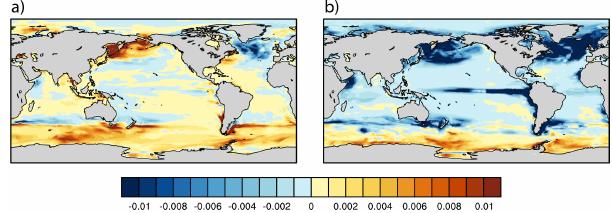
Figure 4. First-order Taylor decomposition of the surface NPP changes between 2012–2032 and 2080–2100 in (a) biomass- weighted changes in growth and (b) growth-weighted changes in biomass. The unit ismolCm − 3 yr − 1